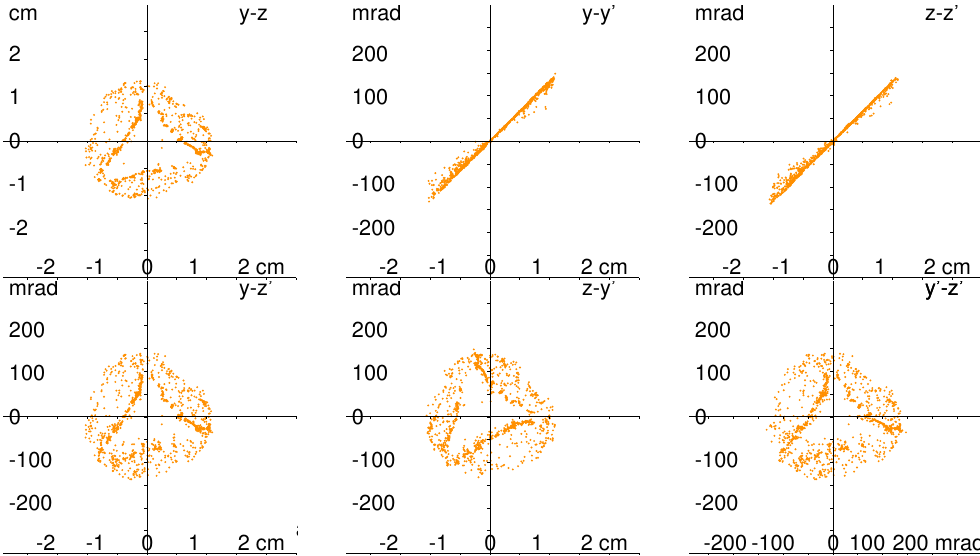
Figure 7. Different projections of the six-dimensional phase space. Top, from left to right: profile y-z, horizontal emittance y-y’, vertical emittance z-z’. Bottom, from left to right: y-z’, z-y’ and y’-z’, at x at the location of ground electrode, all ˙ x . Only one m / q ( 40 Ar 3 + ) is shown here. Simulation made for ECRIS CAPRICE.